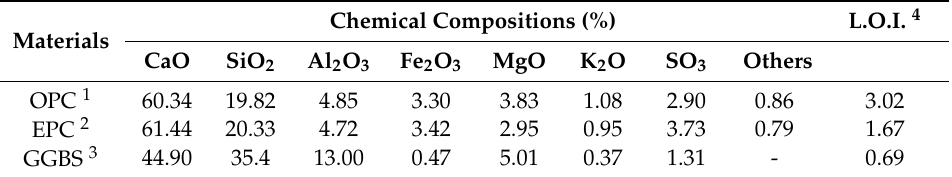
Table 2. Chemical compositions of the used binders.